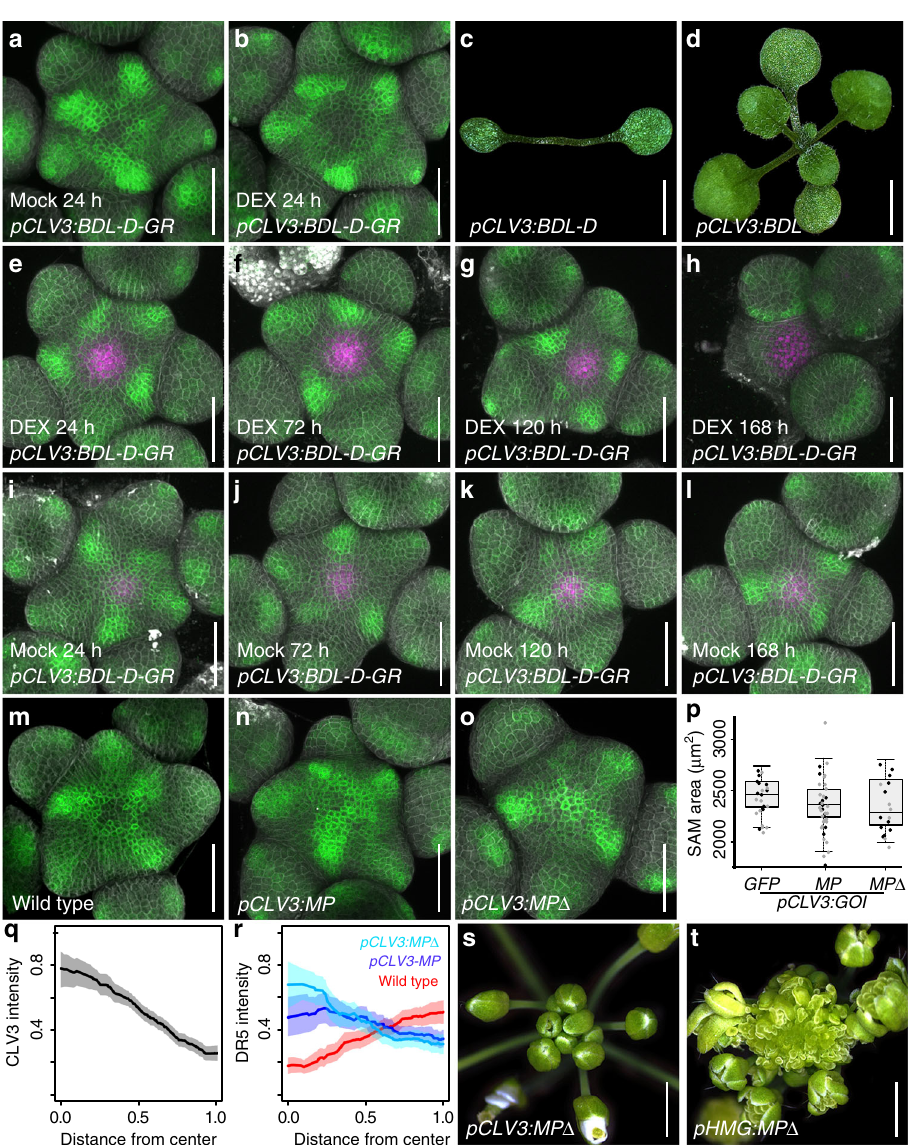
Fig. 3 Stem cells require auxin signaling to remain active, but are resistant to overactivation of the pathway. a pDR5v2:ER-eYFP-HDEL activity in plants harboring pCLV3:BDL-D-GR after 24 h of mock treatment. b DR5v2 signal after 24 h of DEX treatment. c, d Representative phenotypes of lines expressing pCLV3:BDL-D ( c ) and pCLV3:BDL ( d ). e – l Response of DR5v2 and CLV3 to induction of pCLV3:BDL-D-GR over time. pDR5v2:ER-eYFP-HDEL shown in green, pCLV3:mCherry-NLS shown in magenta. CLV3 signal is expanded and sustained until the meristem terminates. i – l Mock treated pCLV3:BDL-D-GR controls. m – o Activity of DR5v2 in SAMs with enhanced auxin signaling in the central zone. m wild type control, ( n ) pCLV3:MP , ( o ) pCLV3:MP Δ . p SAM size quanti fi cations for plants carrying pCLV3:GFP, pCLV3:MP , or pCLV3:MP Δ in two independent T1 populations. q Quanti fi cation of pCLV3:mCherry-NLS signal strength in wild type ( n = 4). r Quanti fi cation of pDR5v2:ER-eYFP-HDEL signal strength in wild type (red, n = 4), pCLV3:MP (light blue, n = 4) and pCLV3: MP Δ (purple, n = 4). In q and r kernel regression was used to visualize dependence of fl uorescence signal from SAM center. 95% con fi dence intervals were simulated using bootstrapping (10.000 iterations) and are shown in lighter colors. s , t Representative phenotypes of lines expressing pCLV3:MP Δ ( s ) and pHMG:MP Δ ( t ). All scale bars 50 µ m, except c and d 2 mm; ( s ) and ( t ) 3.5